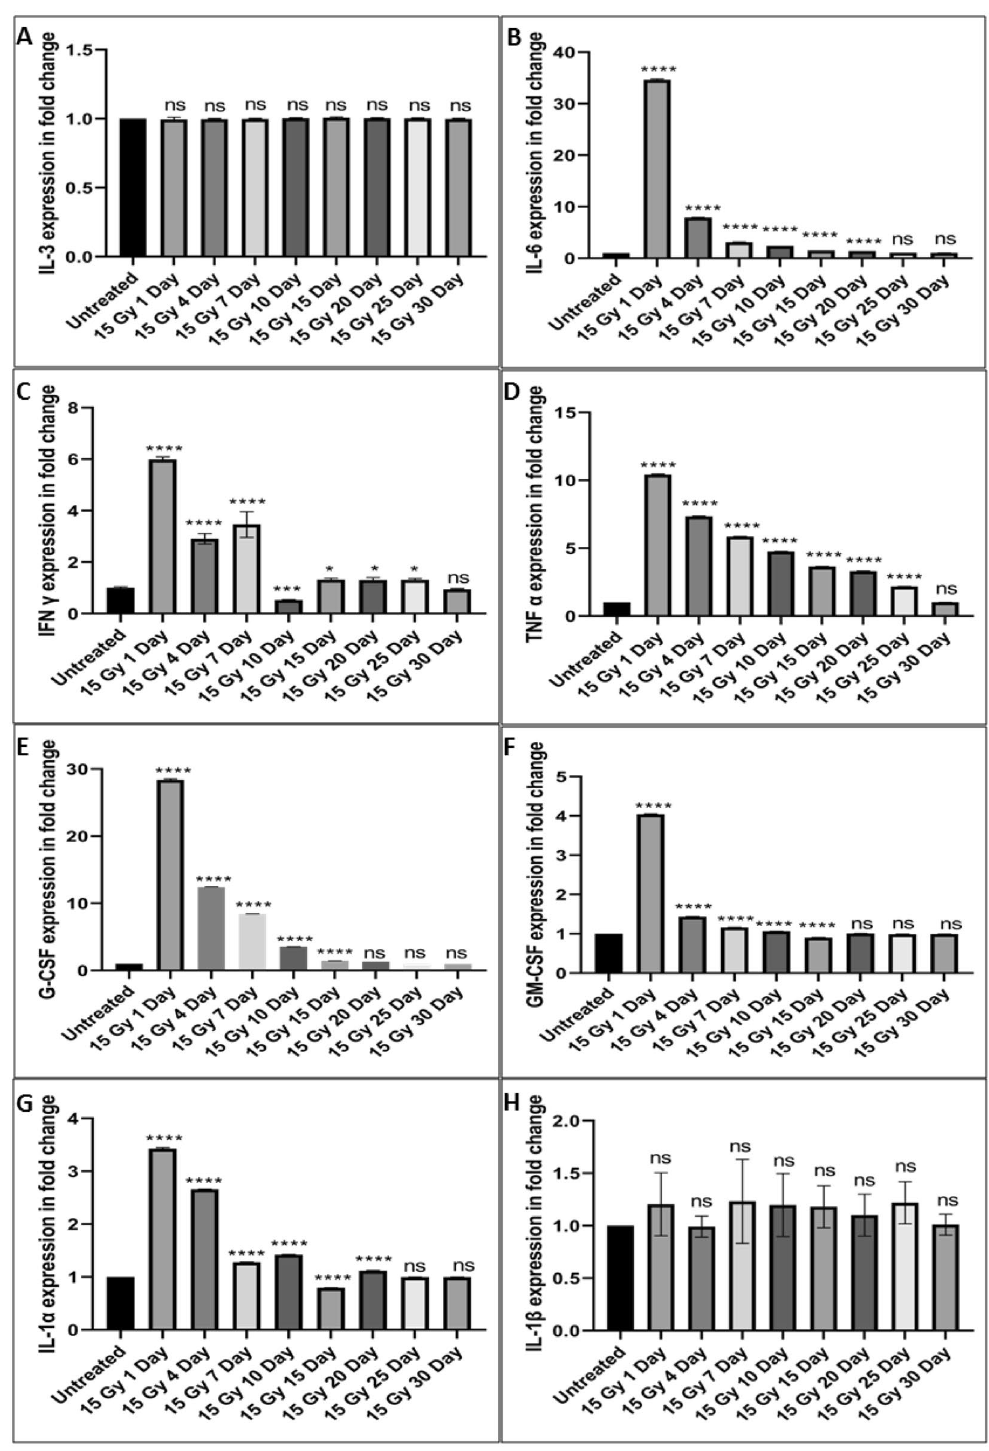
Figure 7. Changes in cytokines levels after localized 15 Gy exposure. ( A – H ) Bars indicate expression of IL-3, IL-6, G-CSF, GM-CSF, TNFα, IFNγ, IL-1α, and IL-1β. The results were analyzed at BD LSR II using BD FCAP Array V3 software. The bars represent the mean ± SD of 6 animals. A value of p < 0.05 is considered statistically significant *p < 0.05, **p < 0.01, ***p < 0.001, ****p < 0.0001, ns = not significant (p >